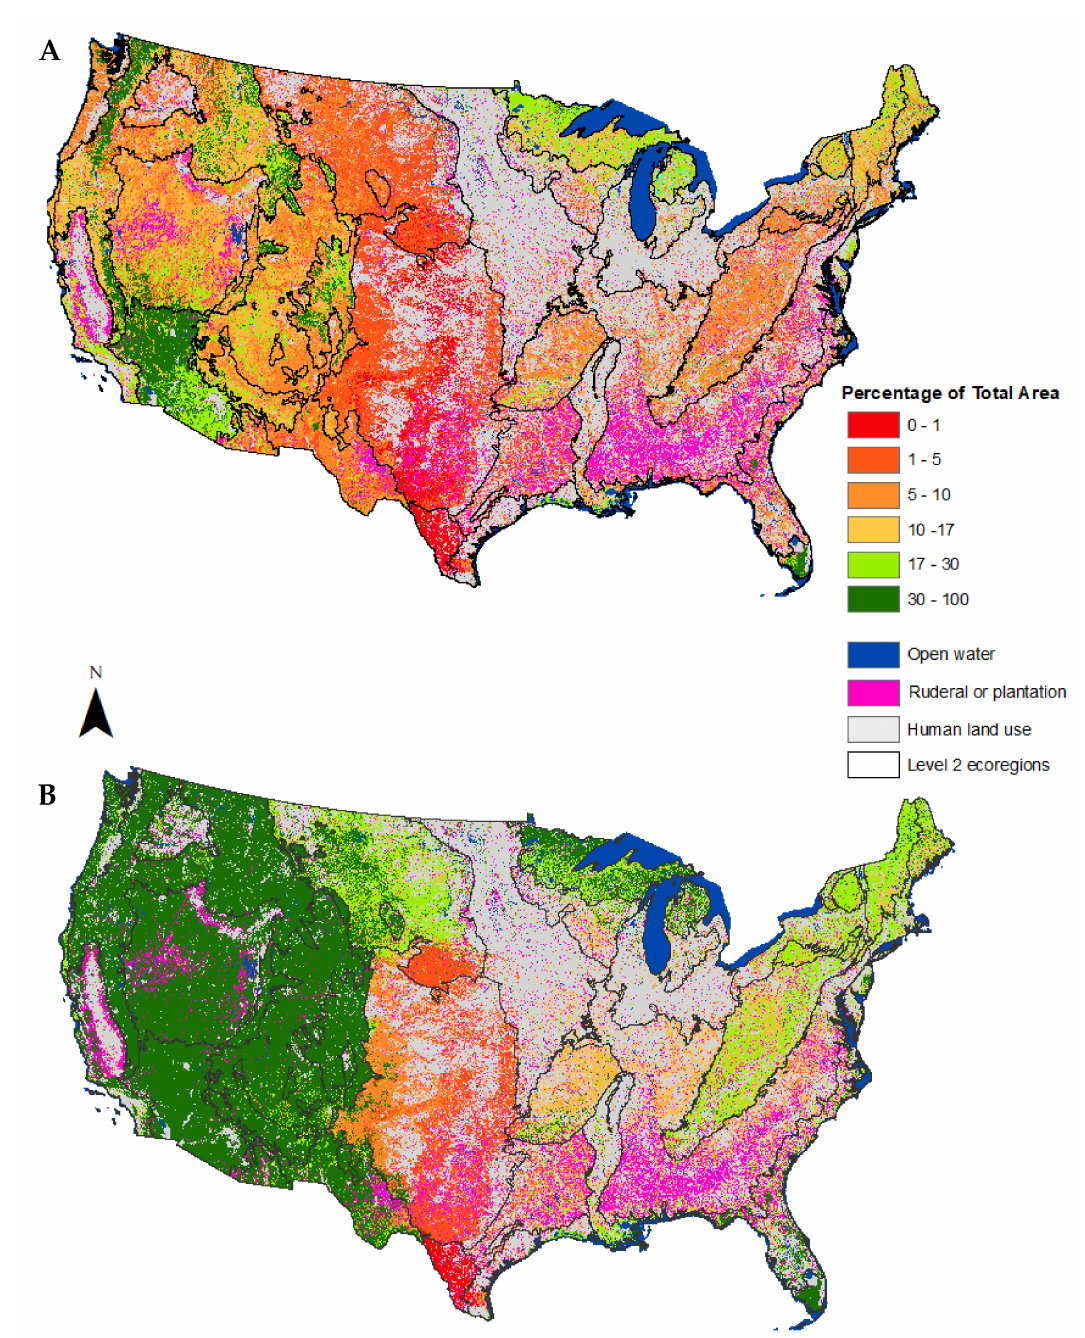
Figure 4. Protection status designations are ( A ) lands managed to maintain biodiversity (Status 1 & 2) and ( B ) lands managed to maintain biodiversity and multiple-use (Status 1, 2, & 3) for the continental US. Percent area is based on the area of each United States National Vegetation Classification Group within each protection status divided by the total area of each of the natural USNVC Group across the conterminous U.S. Areas in pink represent ruderal and plantation vegetation and gray areas are intensively managed or urbanized land uses. Black borders represent the boundaries of the Level II Ecoregions